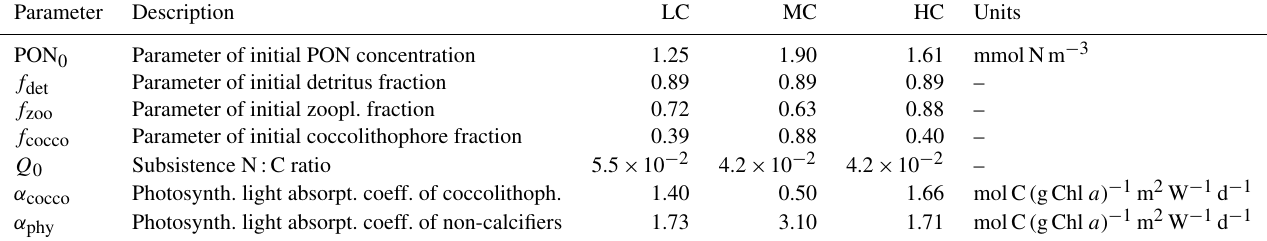
Table 2. Maximum likelihood parameter estimates of three model solutions: low, medium, and high calcification (LC, MC, and HC).